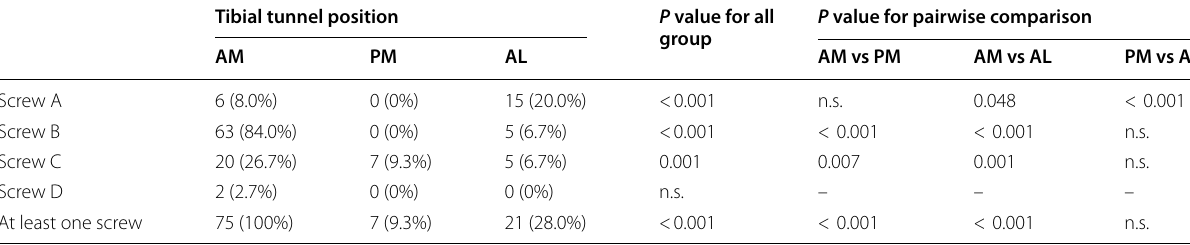
AM Anteromedial, PM Posteromedial, AL Anterolateral